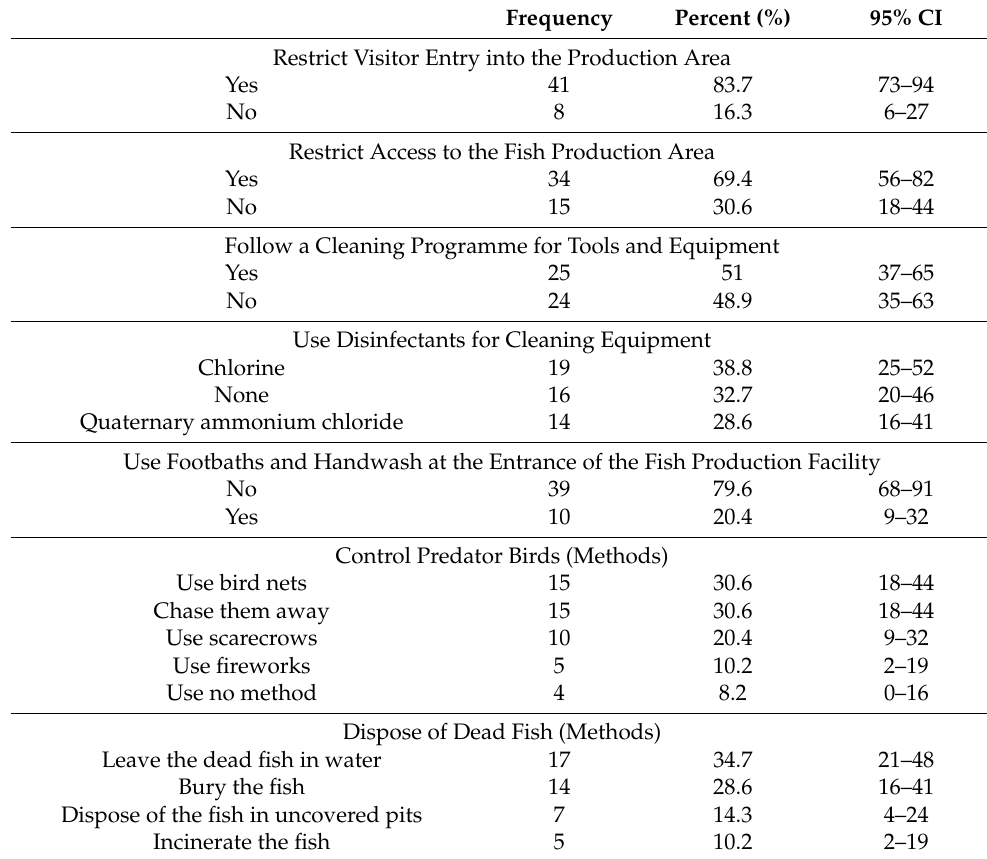
Table 4. Biosecurity